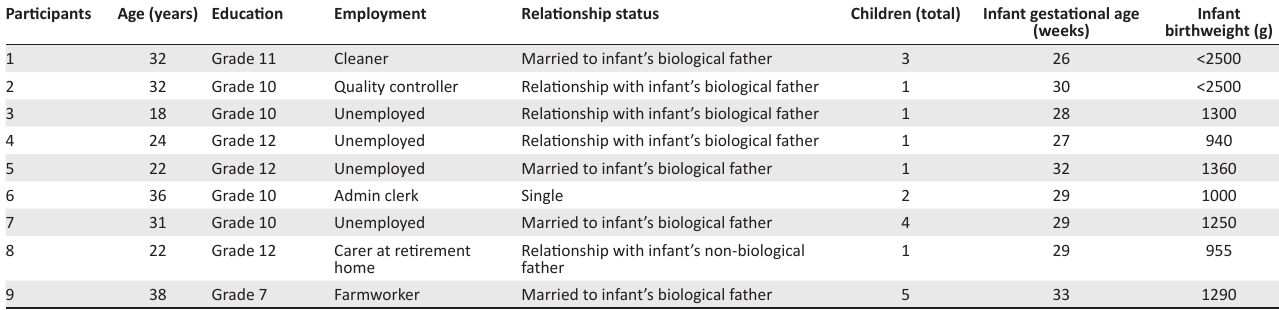
TABLE 1: Characteristics of the nine study